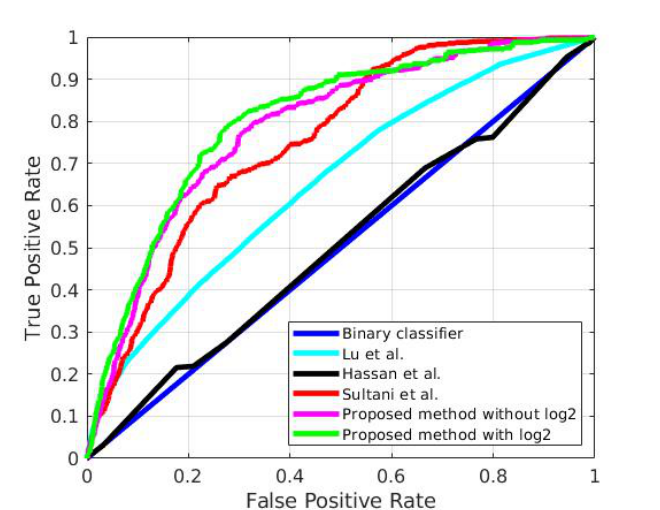
Figure 3. ROC comparison of the base binary classifier (blue), with the proposal in [12] (cyan), the one in [15] (black), the one described in [28] (red) and the proposed in this paper (pink and red, according to the different loss function.) in the UCF-Crime dataset.